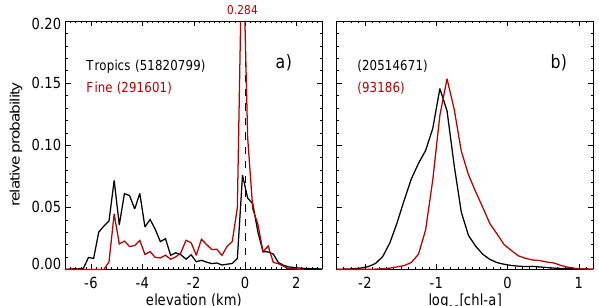
Fig. 9. (a) Shows a comparison of the distribution of surface eleva- tion in the tropics (20 ◦ S–20 ◦ N, in black) and in the “fine” grid cells (in red). The zero line, separating ocean from land, is marked with a dashed line. For the elevation data a bin size of 0.2km is used, and the number of elevations in each classification is noted on the plot in parentheses. (b) Shows a similar plot for the chlorophyll a concentration measured by SeaWiFS. These data (original units are mgm − 3 ) are log-transformed, and a bin size of 0.1 is used. Again, the total number of pixels contributing to each distribution is noted in